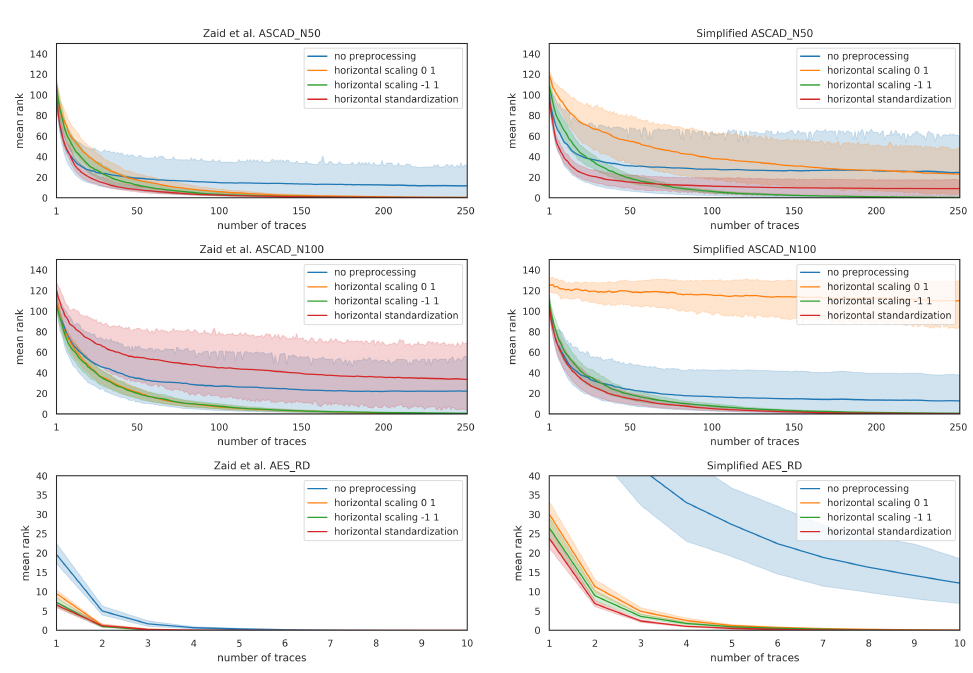
Figure 2: Comparison between the models proposed by Zaid et al. (left) and those same models without the first convolutional layer (right). The models are trained on the misaligned datasets using different preprocessing techniques. Best viewed on screen.